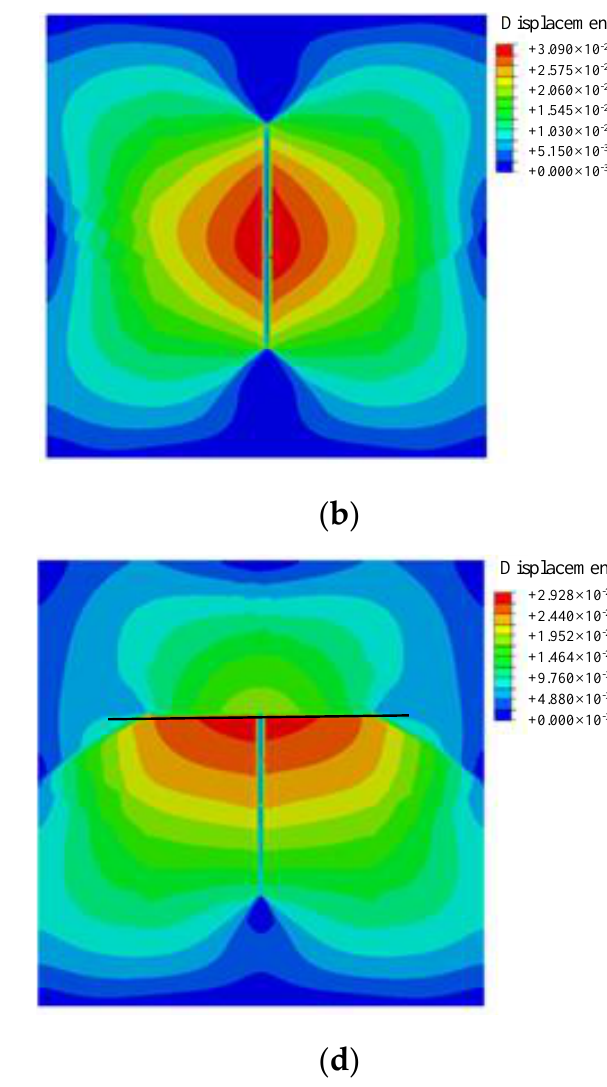
t = 55 s; and ( d ) elastic modulus of 45 Gpa and t = 100